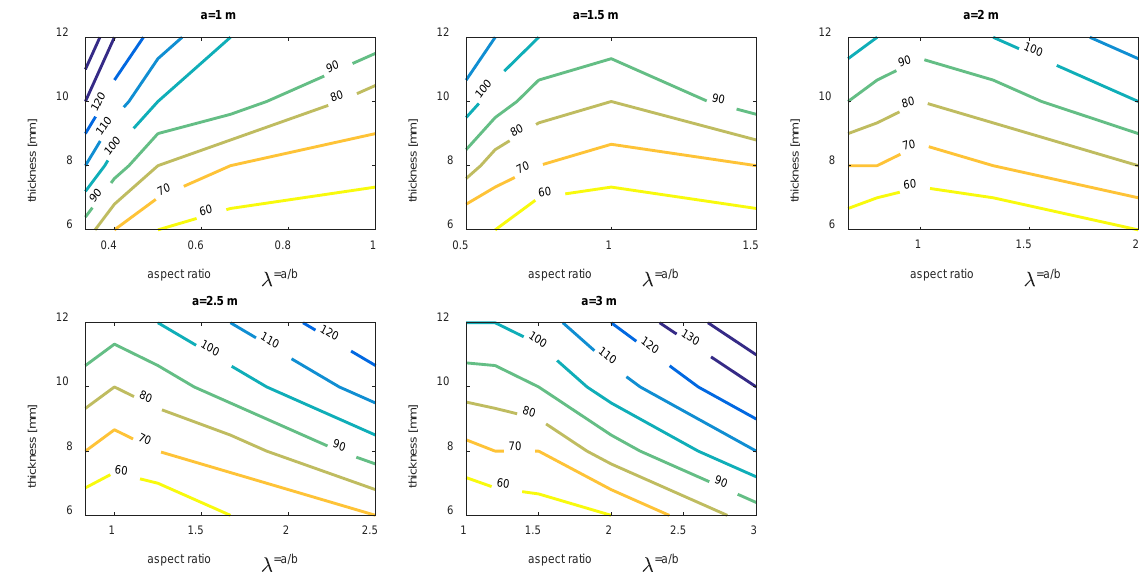
Fig. 6 Four-point supported glass plate. Buckling limits for different plate size, aspect ratio and